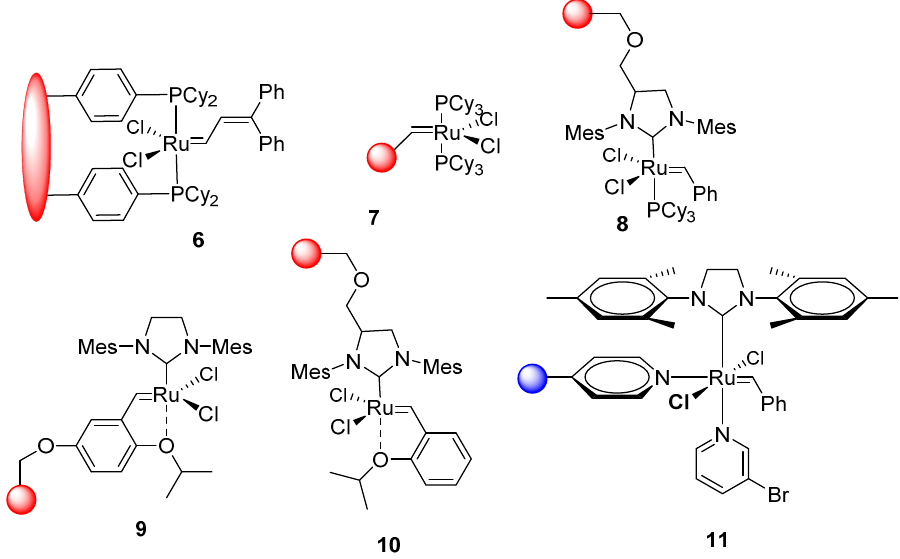
Figure 2. Examples of DVB-PS-supported ( = divinylbenzene cross-linked polystyrene or = divinylbenzene cross-linked 4-vinylpyridine) olefin metathesis catalysts 6–11 .